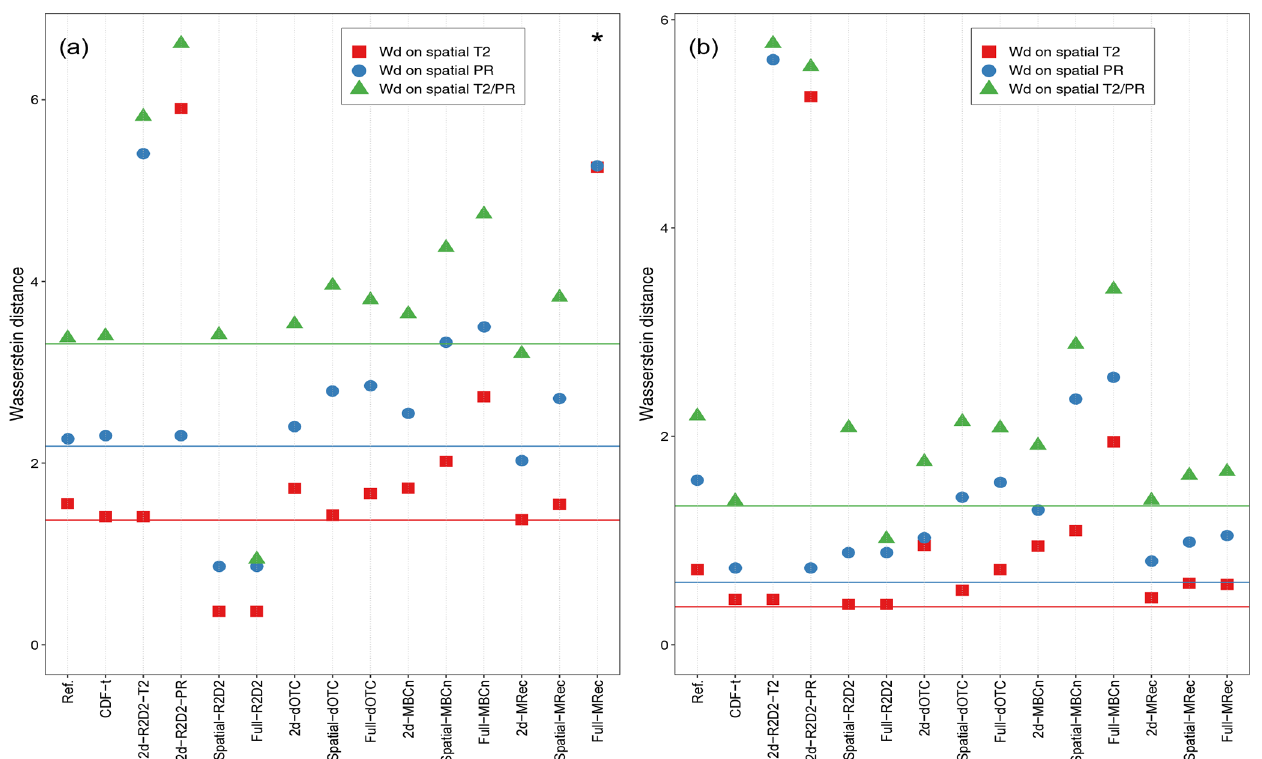
Figure 7. Values of the three Wasserstein distances on ranks between 1979–1997 and 1998–2016 periods during winter for temperature (square), precipitation (circle) and both temperature and precipitation (triangle) for the region of (a) France and (b) Brittany. Results are presented for the reference, plain IPSL (lines), CDF-t and the different MBCs. 2d-R 2 D 2 -T2 (resp. 2d-R 2 D 2 -PR) indicates results for 2d- R 2 D 2 with temperature (resp. precipitation) used as reference dimension. Black asterisks indicate values lying outside the plotted